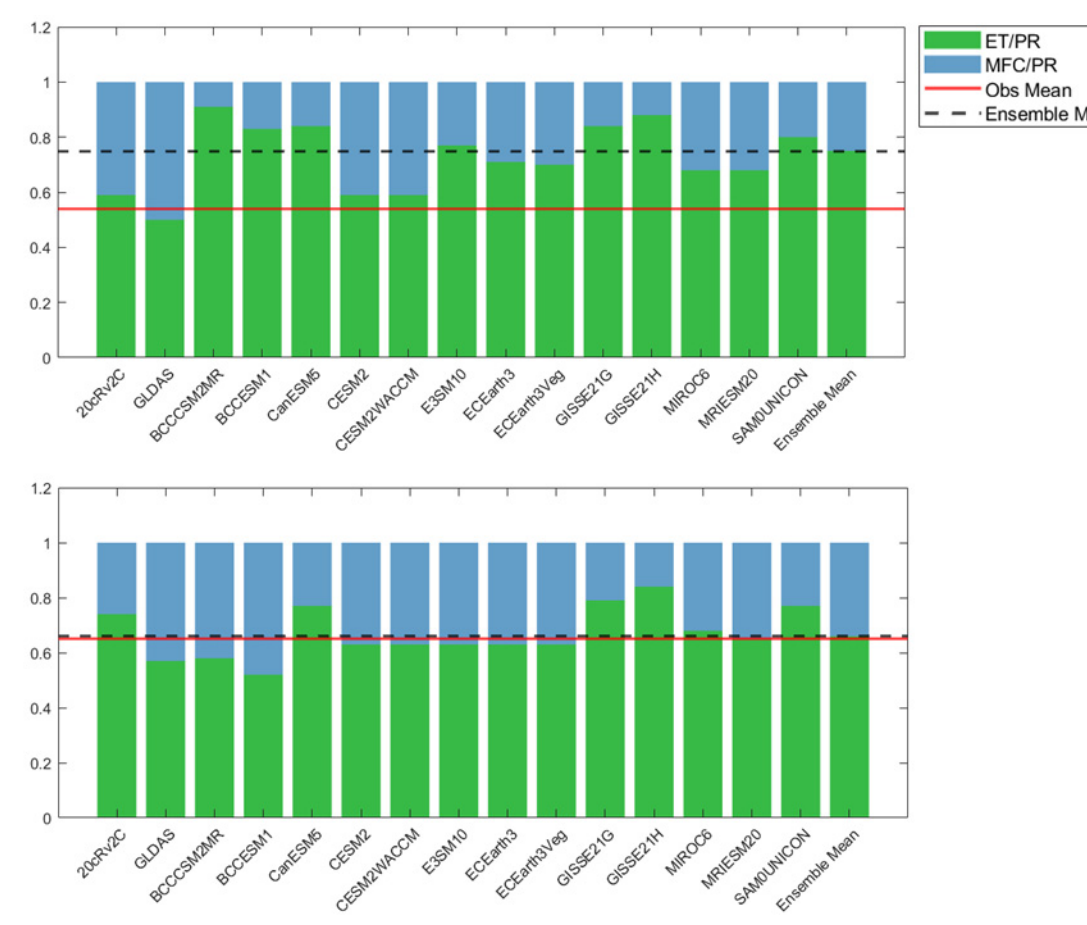
Figure 13. The 1981–2014 ET/PR (green) and MFC/PR (blue) ratio analysis with observation mean (red line) and ensemble mean (black dashed line) ET/PR analysis for northern Amazon (NAZ—( top ) panel) and southern Amazon (SAZ—( bottom ) panel) for GLDAS and 20cRv2C reanalysis, and GCMs. erage of GLDAS and 20cRv2C ratio values) are CESM2 (0.05), CESM2WACCM